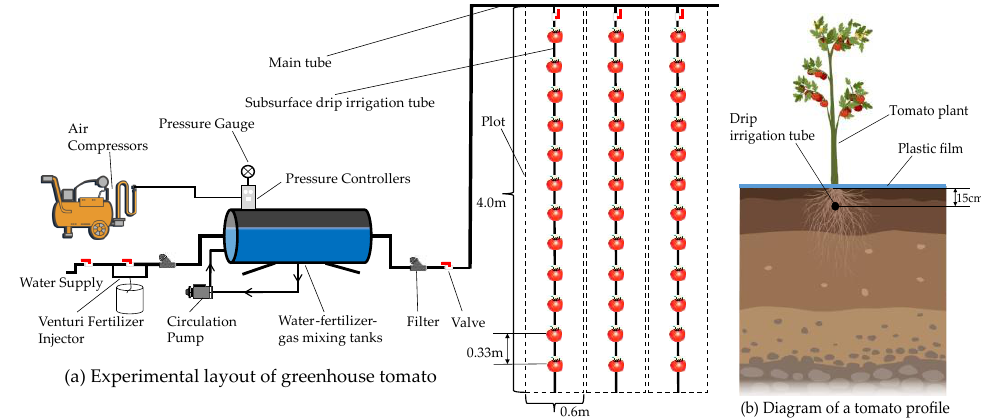
Figure 2. Diagram of experimental layout ( a ) and plant profile ( b ) of greenhouse tomato.